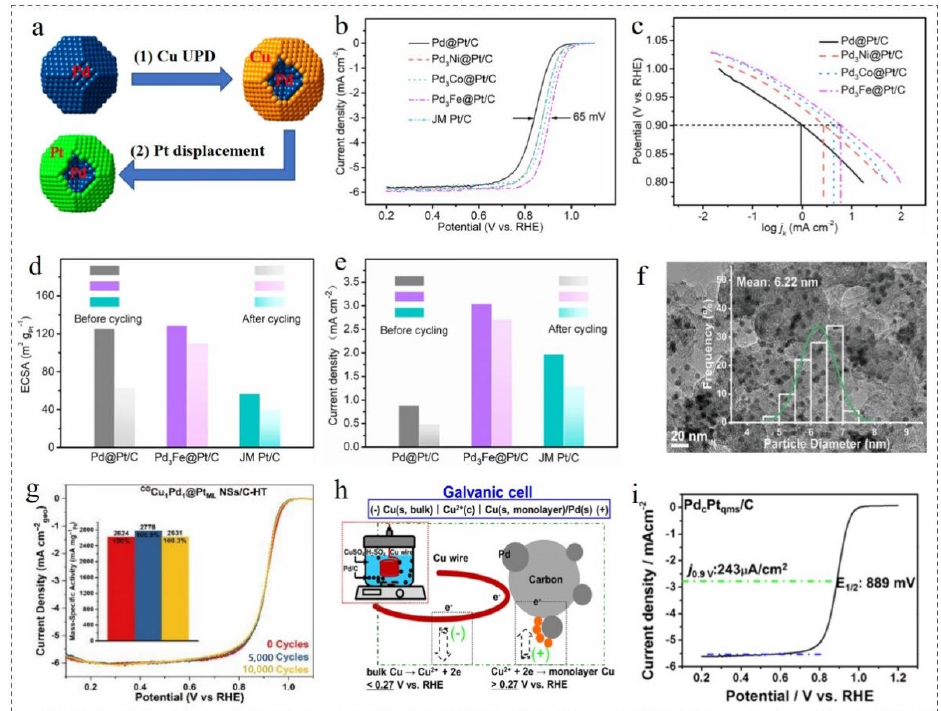
Figure 2. ( a ) Schematic Illustration of UPD process with copper as sacrificial layer.